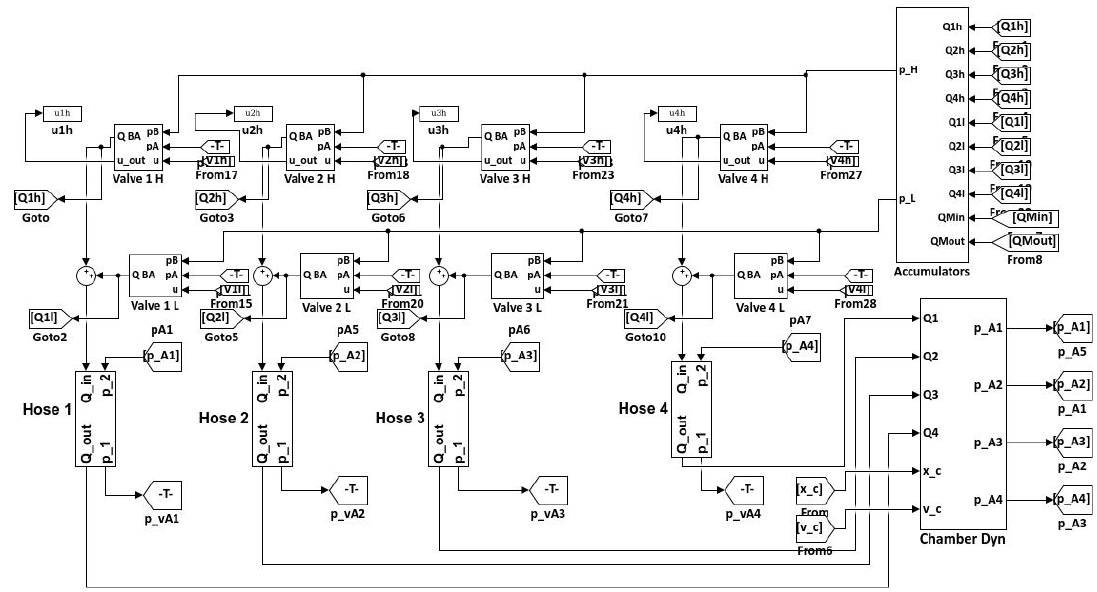
Figure 8. The Simulink model of the hydraulic PTO